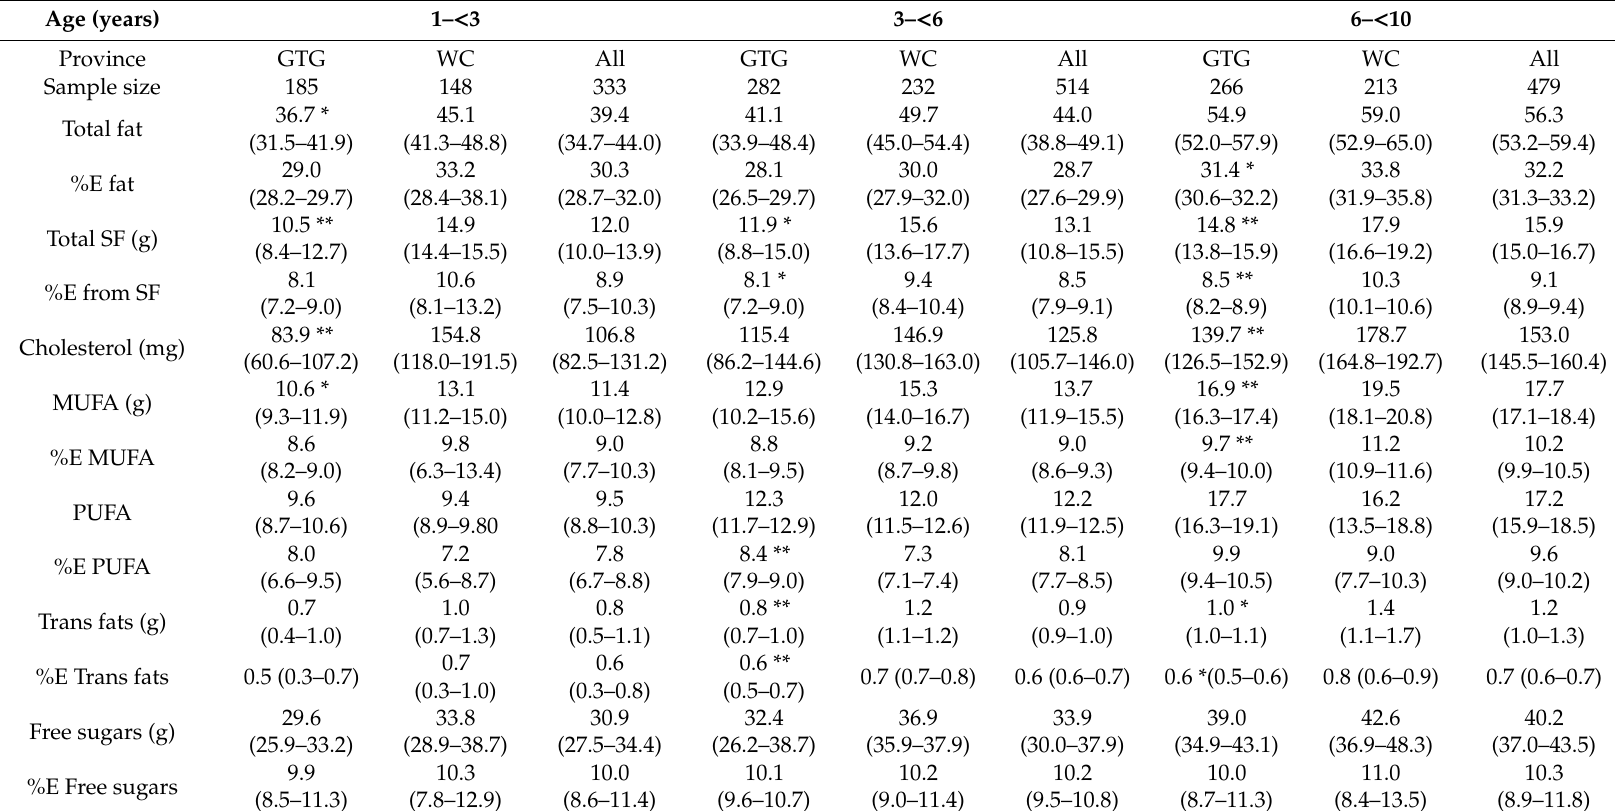
Table 4. The mean (95% CI) fat and free sugars intake of children aged 1– < 10-years by province and age